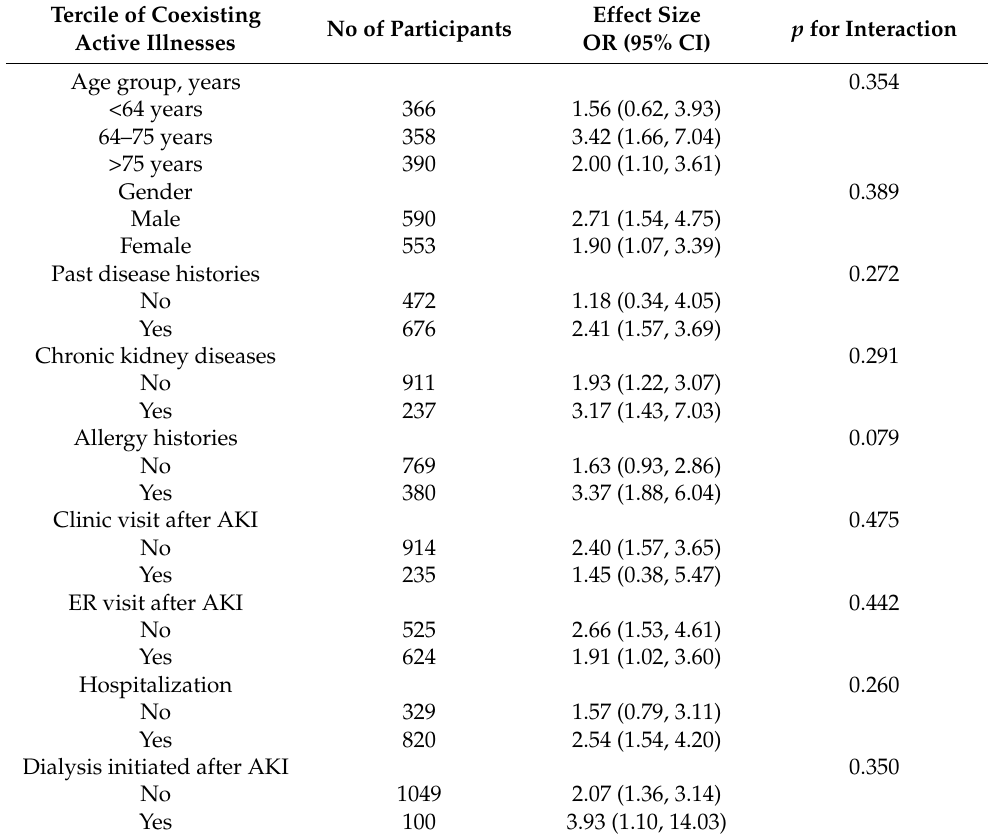
Table 4. The effect size on deceased AKI patients after COVID-19 vaccines and exploratory